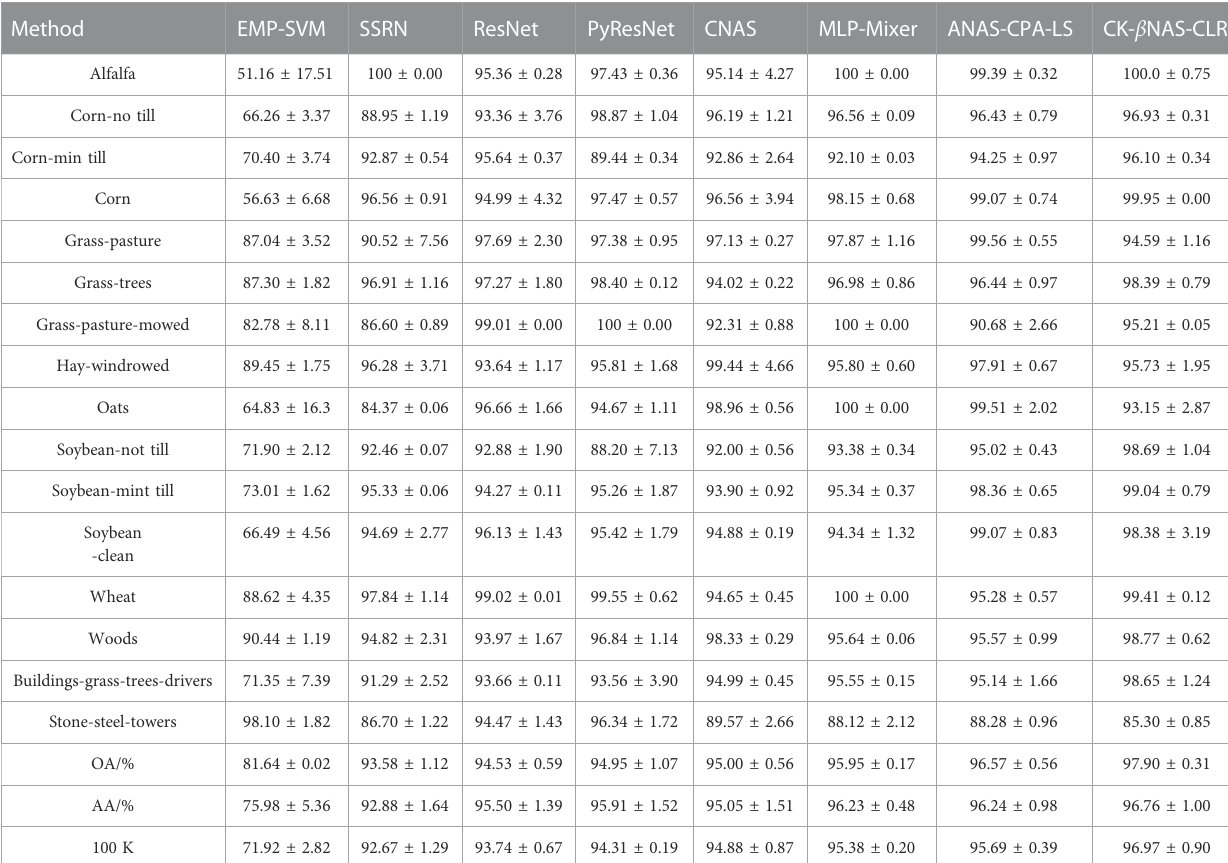
TABLE 1 Performance comparison of different methods of the Indian Pines